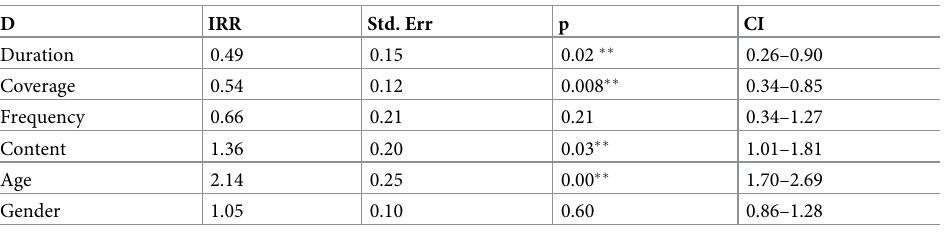
Table 2. Relationship of fidelity elements with decay